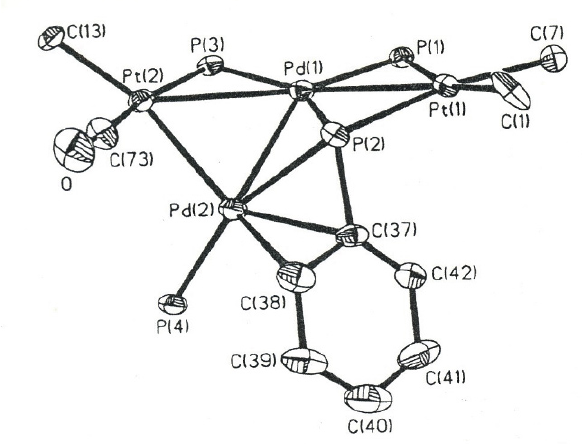
Figure 5. Schematic view of the central core of [(C